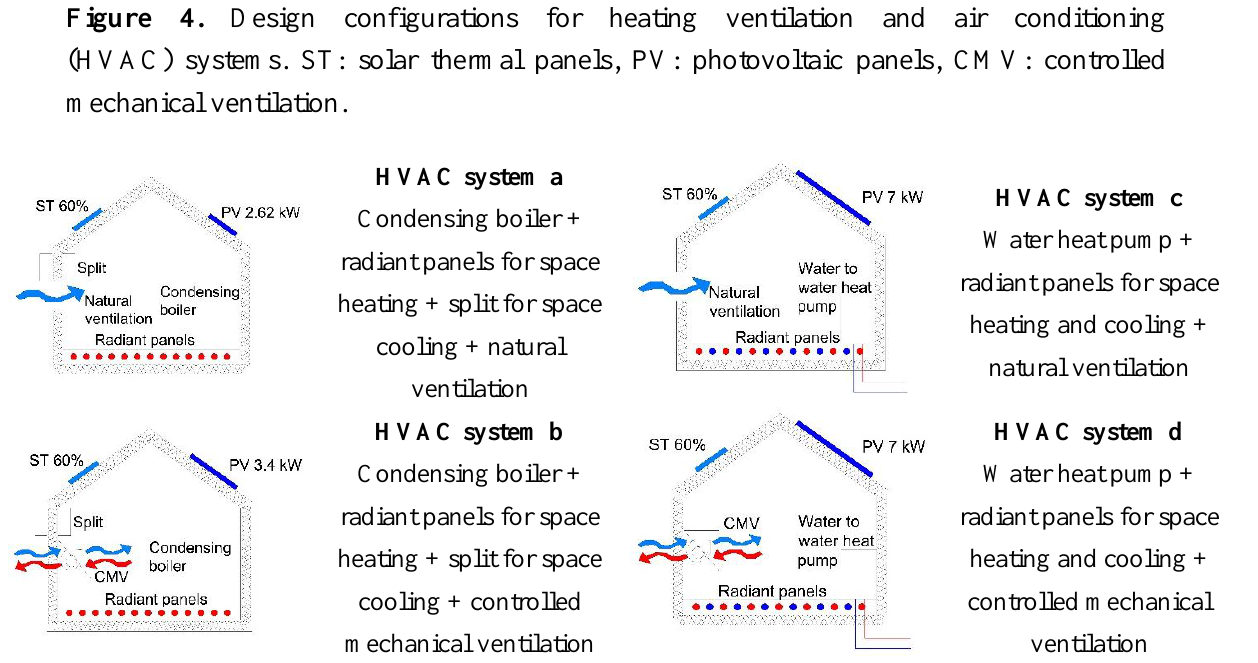
HVAC system c Water heat pump + radiant panels for space heating and cooling + natural ventilation HVAC system d Water heat pump + radiant panels for space heating and cooling + controlled mechanical